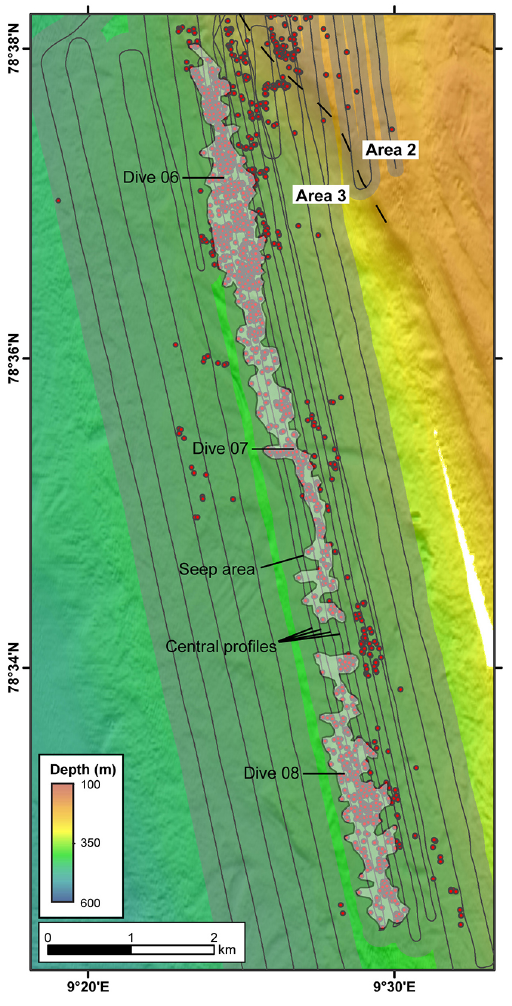
Figure 8. Position of flares (circles) found in Area 3 (“396m flares”) plotted on shaded bathymetry. Flares were picked in multi- beam water column data; the coverage is shown as dark-gray shad- ing around the ship track (lines). In this study we defined a “seep area” (light-gray shading) in which the number of flares was quan- tified using the four central profiles (see Fig. 9). The approximate locations of three ROV dives (06–08) are indicated.